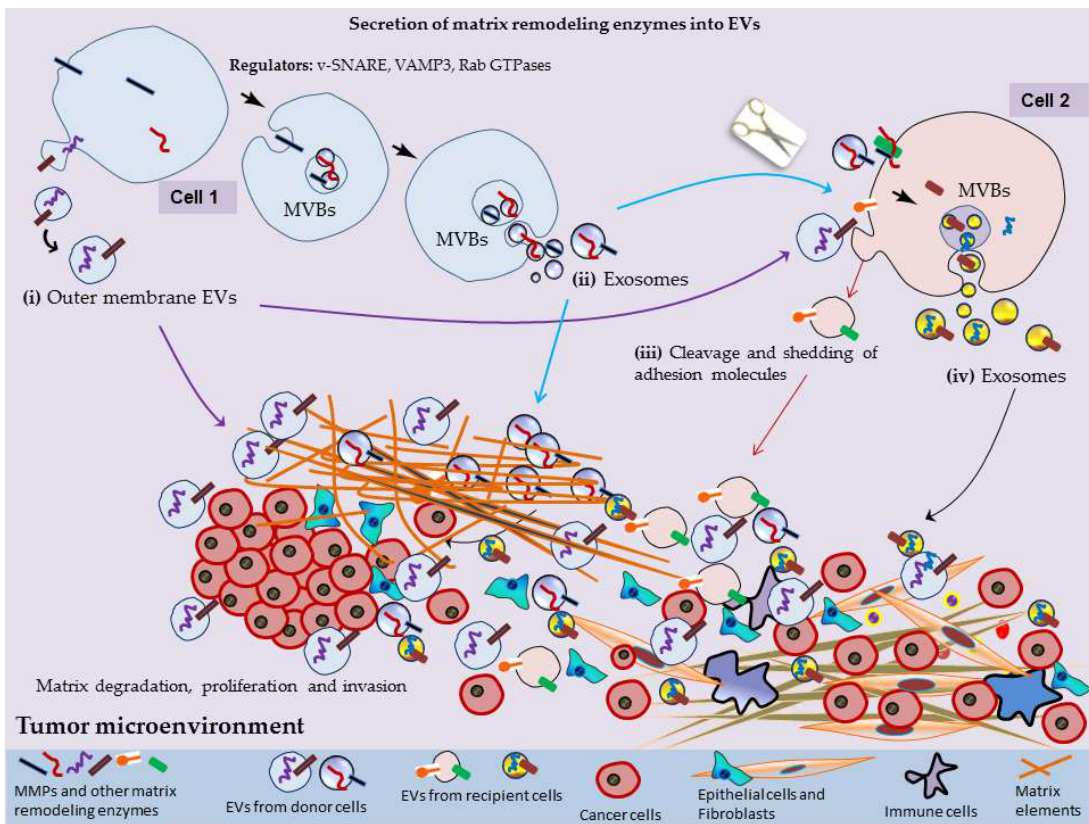
Figure 1 . Schematic illustration of secretion of extracellular vesicles (EV)-associated matrix degrading enzymes, matrix remodeling and tumor progression: EVs (both outer membrane microvesicles and endosome-derived exosomes: (i) and (ii) respectively) secreted from cells carry plethora of matrix degrading enzymes on their surface or packed inside the lumen of EVs. EV-associated matrix cleaving enzymes are secreted along the entire cell periphery and can interact with neighboring cells (cell 2) whereby they cleave the surface proteins, transmembrane and adhesion molecules of recipient cells, which are either packaged into the outer membrane vesicles of recipient cells or shed directly into cells’ periphery (iii). Additionally, EVs taken up by recipient cells can induce further production of matrix metalloproteinases (MMPs) and their release via EVs of recipient cells (iv). Such activities occurring along the cell periphery play active roles in matrix degradation and facilitate cellular invasion, metastasis and preparation of tumor permissive niche. MVBs: multivesicular bodies .